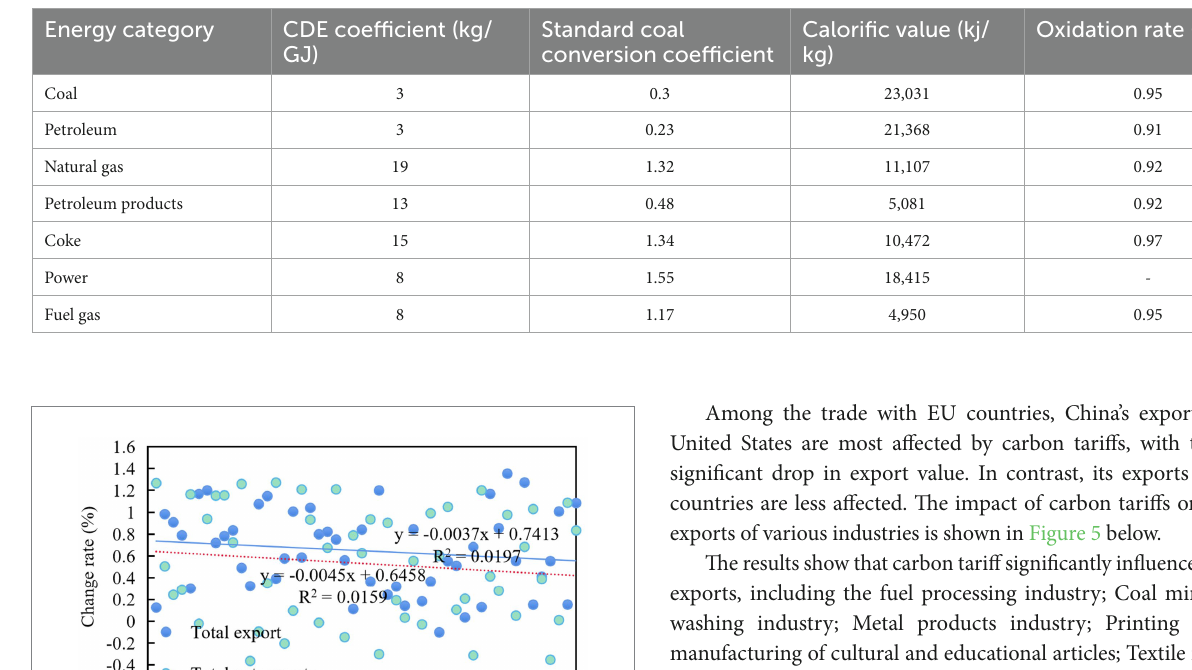
TABLE 2 Conversion coefficient of CDE quantity.